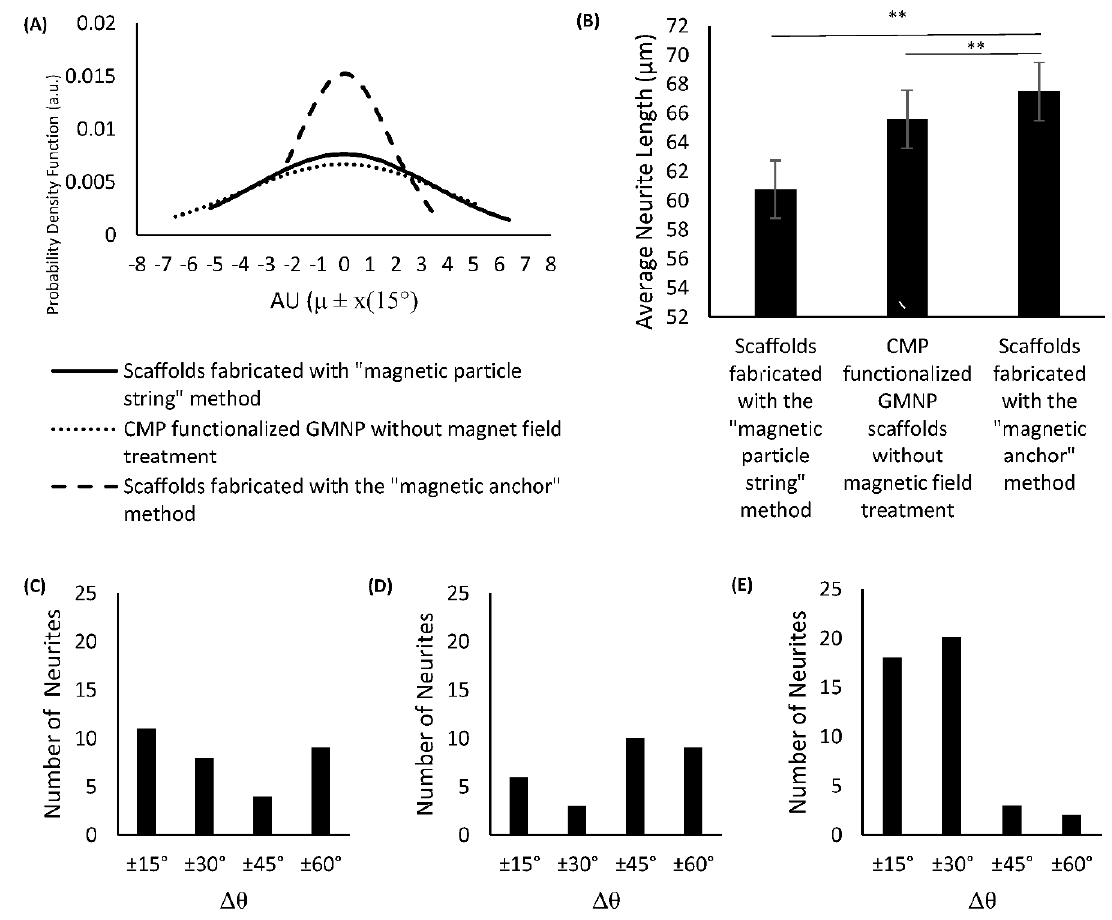
Figure 6. Image ( A ) shows a modified standard normal distribution curve (with µ = 0 and σ = 15° for all samples) of axons’ angle of deviation from the mean angle of alignment. Image ( B ) shows a comparative bar chart representing neurite length of differentiated PC12 cells for treatments that exhibited neurite extensions. ( C – E ) show histograms of PC12 neurite angle of deviation from the mean value, binned at 15°, of: ( C ) scaffolds fabricated with the “magnetic particle string” method (chi-square 1.8413, df 3, and p = 0.605989), ( D ) CMP-functionalised GMNP collagen scaffolds without magnetic field treatment (chi-squared 13.3878, df 3, and p = 0.003868), and ( E ) scaffolds fabricated with the “magnetic anchor” method (chi-squared 11.8351, df 3, and p = 0.00797). ** p < 0.01.